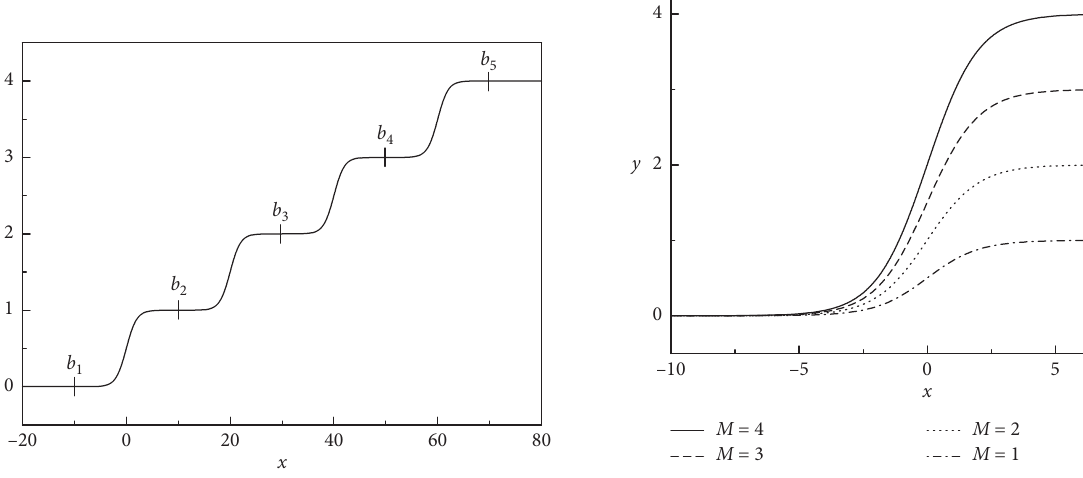
Figure 6: Logistic function synthesis diagram.